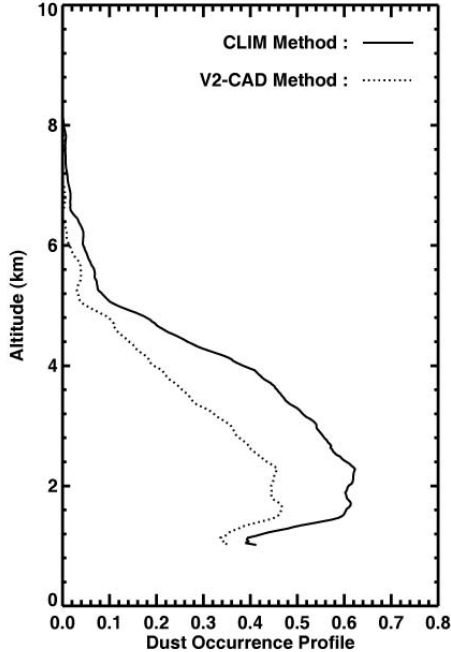
Fig. 10. Mean vertical profiles of dust aerosol occurrence from CALIPSO observations by V2-CAD method (dotted line), and CLIM (solid line) over Taklamakan desert for elevations below 3km during spring